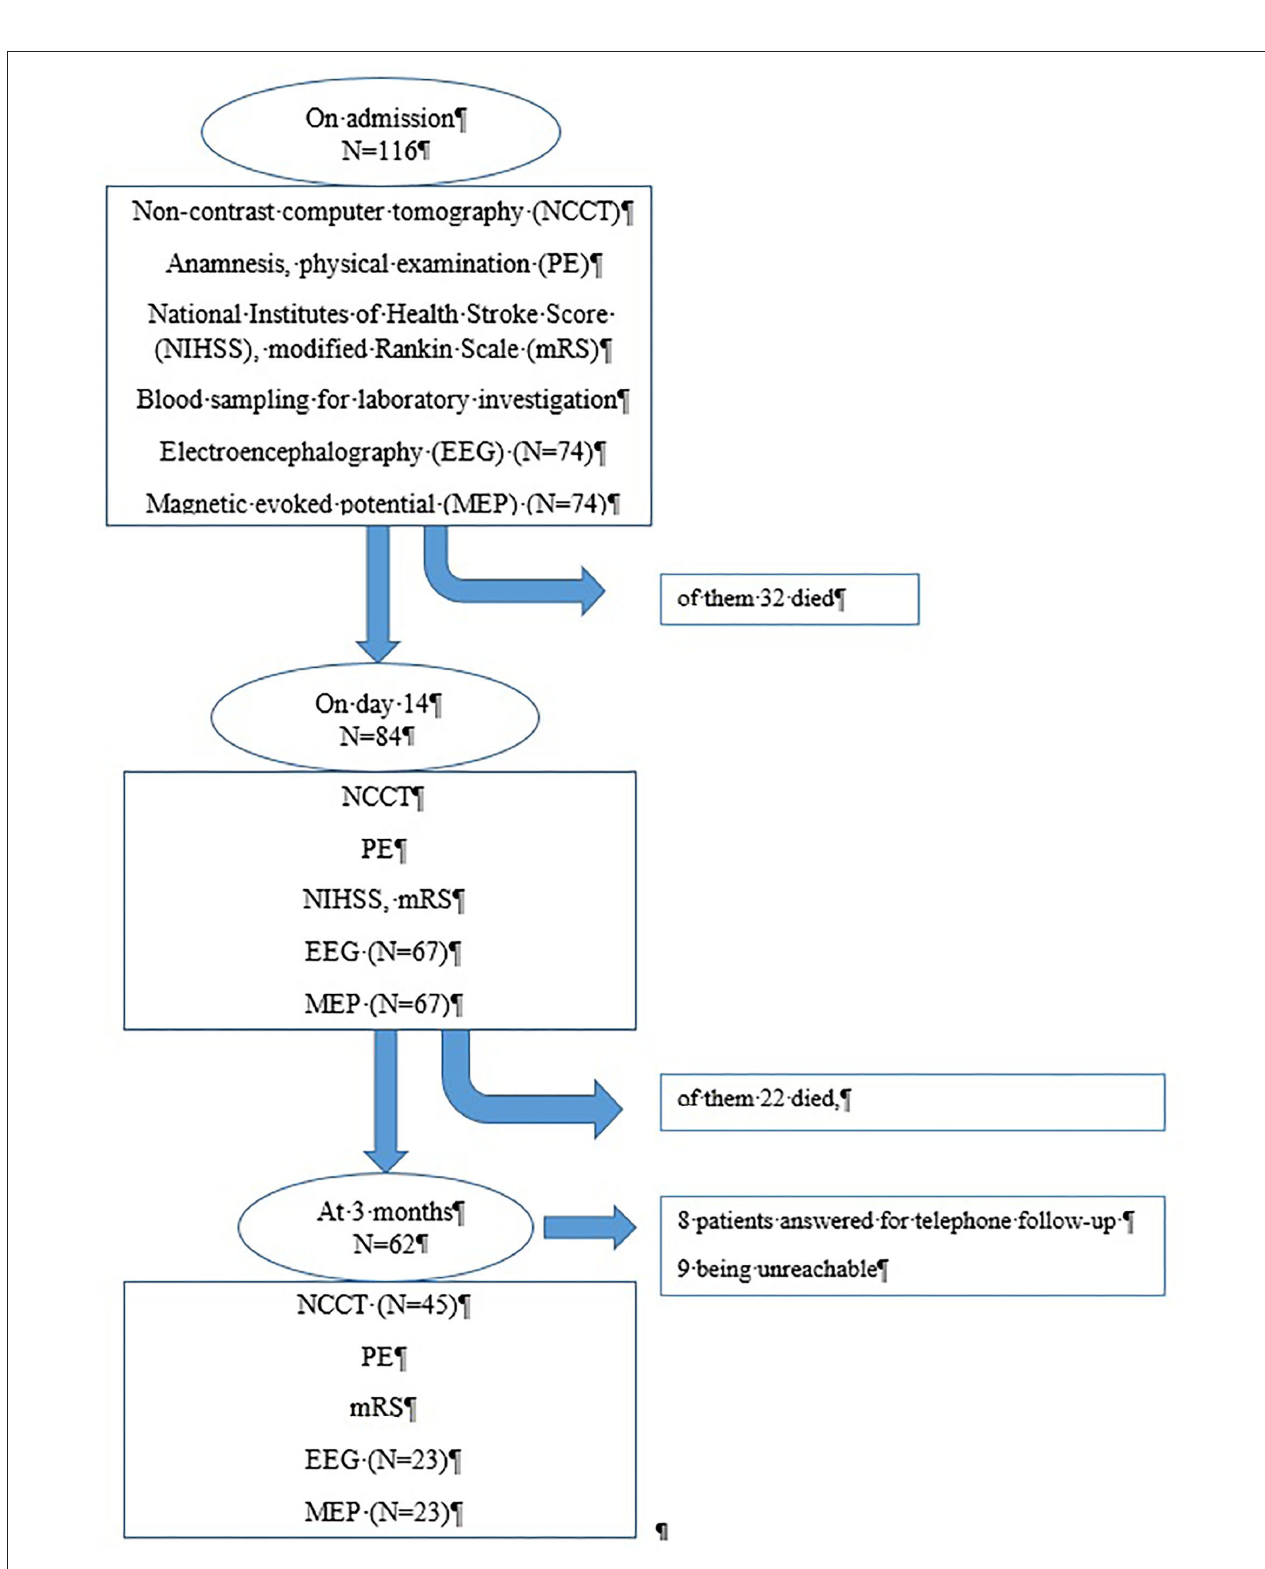
FIGURE 1 | Flowchart: examination of the patients admitted for brain hemorrhage.